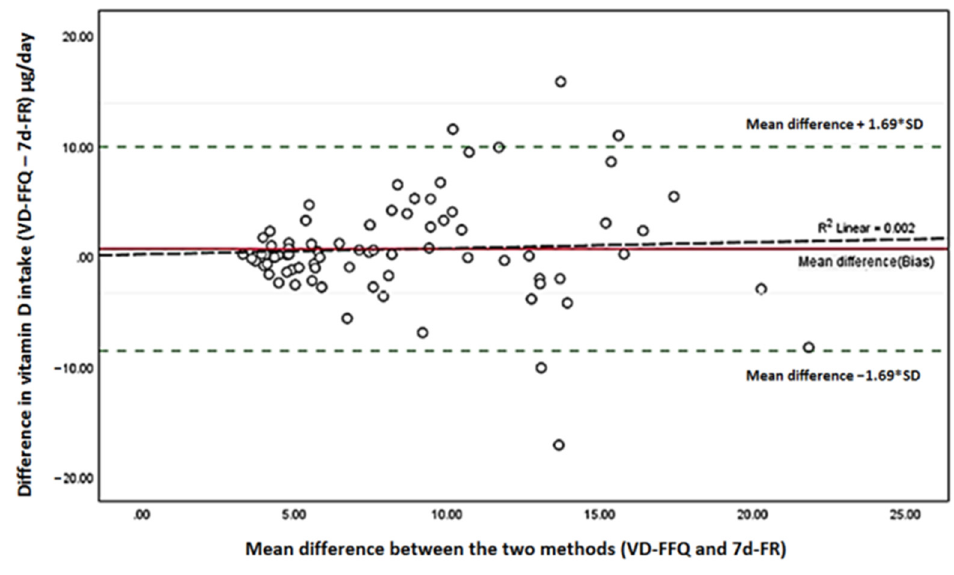
Figure 3. Bland–Altman plot showing agreement between food frequency questionnaire (FFQ) and seven days food record (7d-EDR) for vitamin D daily intake in 152 participants.